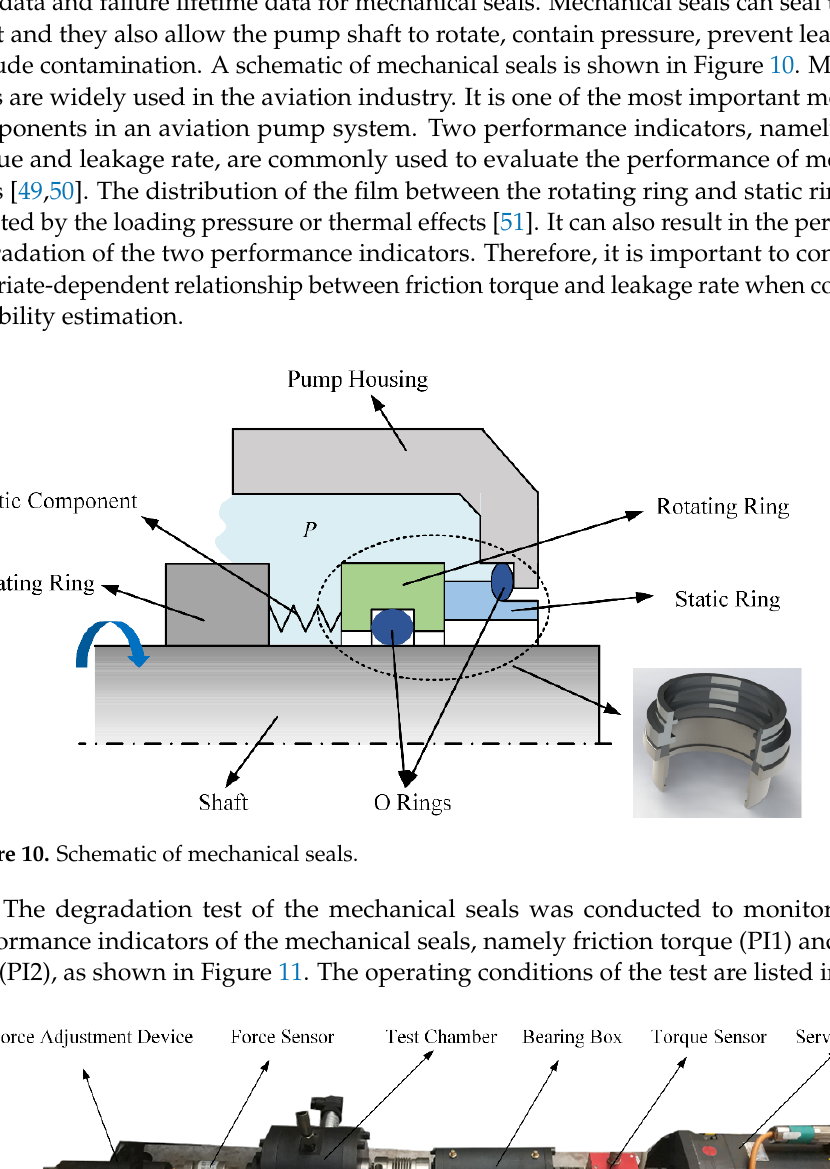
Figure 9. RUL PDF comparison.